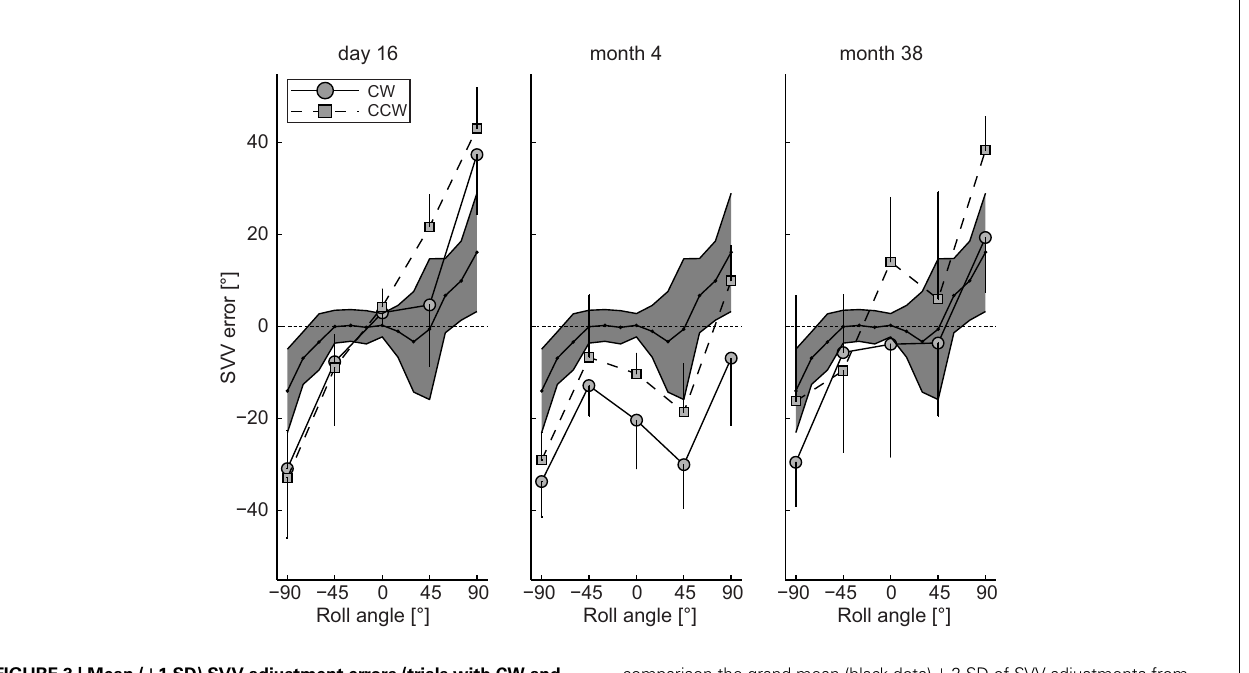
FIGURE 3 | Mean ( ± 1 SD) SVV adjustment errors (trials with CW and CCW arrow rotations analyzed separately) plotted against whole-body-roll in the patient at day 16, month 4, and month 38. For